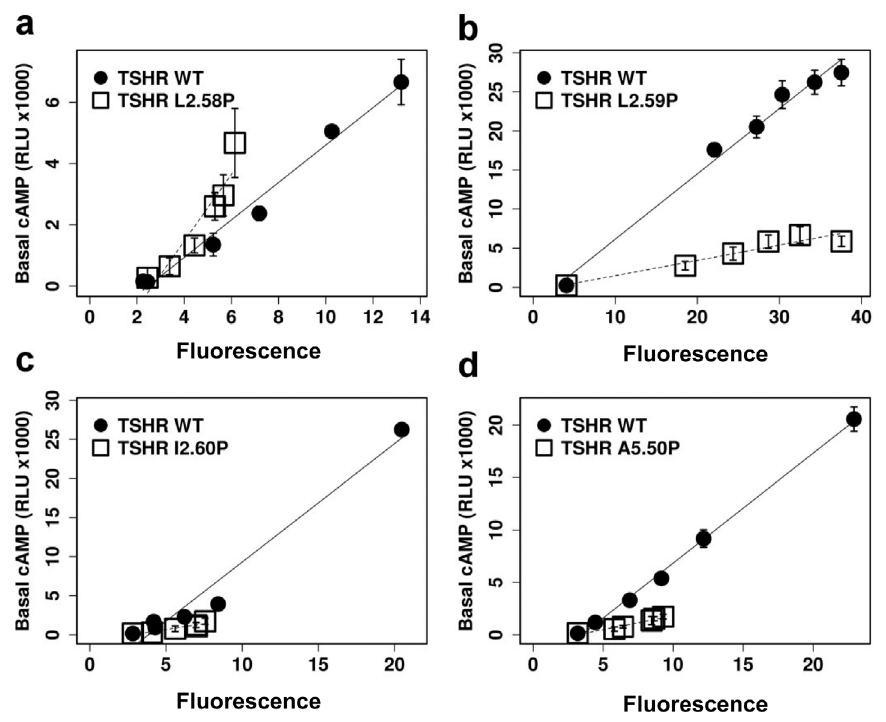
Fig 6. Constitutive cAMP activity of TSHR mutants. Typical measurements of the constitutive activity of the L2.58P (a), L2.59P (b), I2.60P (c) and A5.50P (d) TSHRs. In each panel, the cAMP accumulation obtained in the presence of the mutated and WT TSHR is indicated by open and closed symbols, respectively.